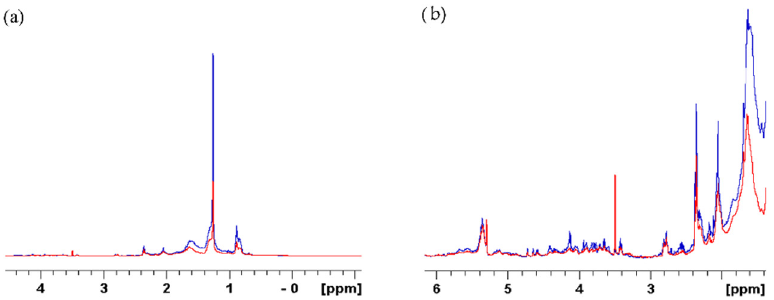
Figure 3. ( a ) Stack plot comparison of 1D 1 H spectra of E. foeminea methanolic (red) and ethyl acetate (blue) extracts; ( b ) extended region ( δ 4 ‒ 3.2) dissolved in CDCl3 and recorded using 500 MHz NMR.